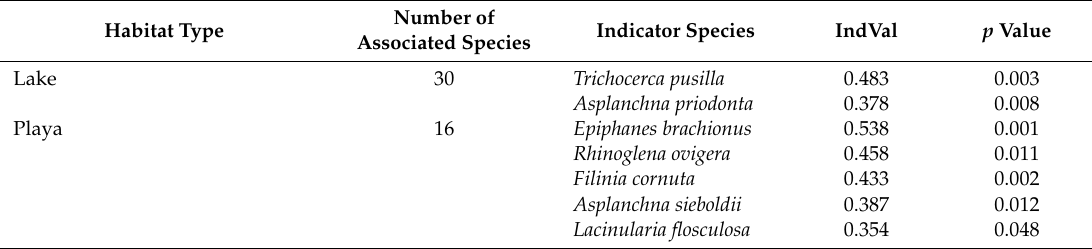
Table 2. Rotifer indicator species by habitat type for 236 waterbodies in the Chihuahuan Desert. Only those combinations of habitat types with significant associations are reported. Indicator value (IndVal) is the test statistic and p values were calculated using permutation